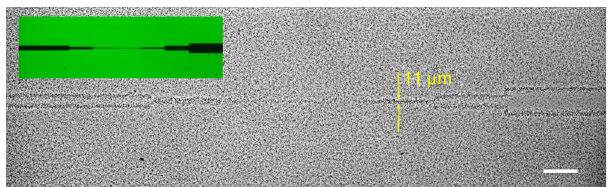
Fig. 5 Spatial resolution for AD10 strain. A pattern of dark lines of different width (see inset; nominal line width on the sample from left to right: 45, 22, 6, 3, 11, 45 and 90 μ m) is projected onto a dense (OD ≈ 8) sample of AD10. At low swimming speeds ( v = 2.7 μ m s − 1 ) the 11 μ m-wide line still shows up clearly while the density contrast for the thinner lines is very low. Scale